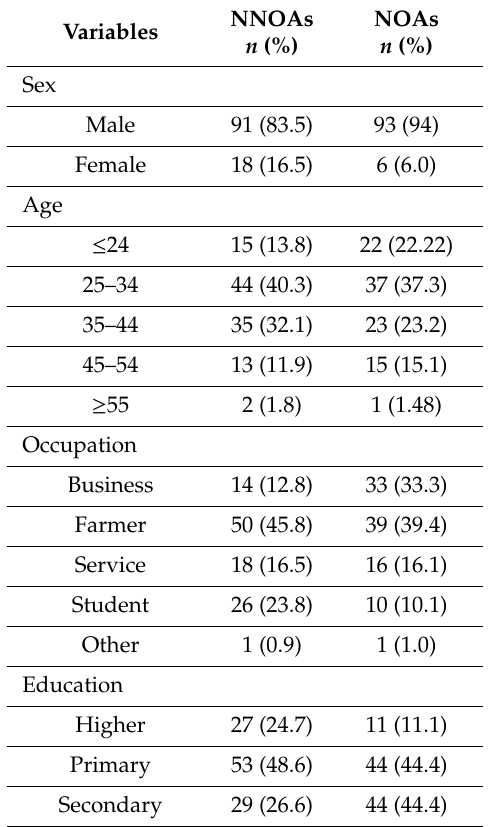
Table 1. The demographic characteristics of study participants.